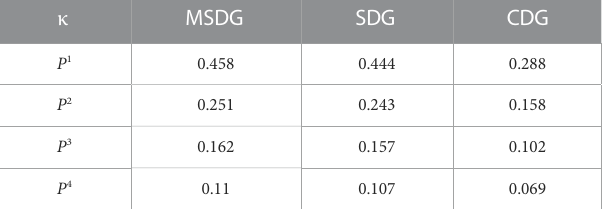
Frontiers in Earth